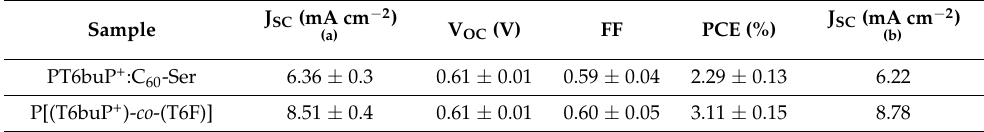
Table 5. Short-circuit current density (J SC ), open-circuit voltage (V OC ), fill factor (FF) and power